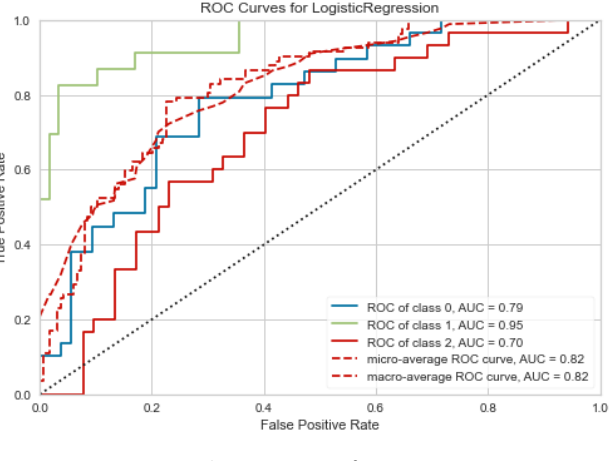
Fig. 9. ROC curve for LR.